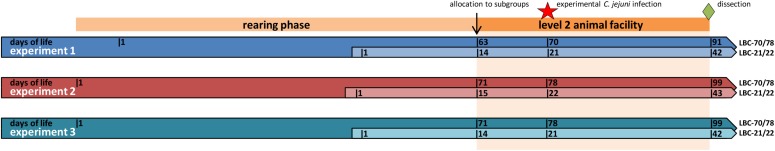
Schedule of the experiments with actions in chickens of different ages at infection (LBC-21/22, Lohmann Brown-Classic, infection at the age of 21/22 days; LBC-70/78, Lohmann Brown-Classic, infection at the age of 70/78 days).